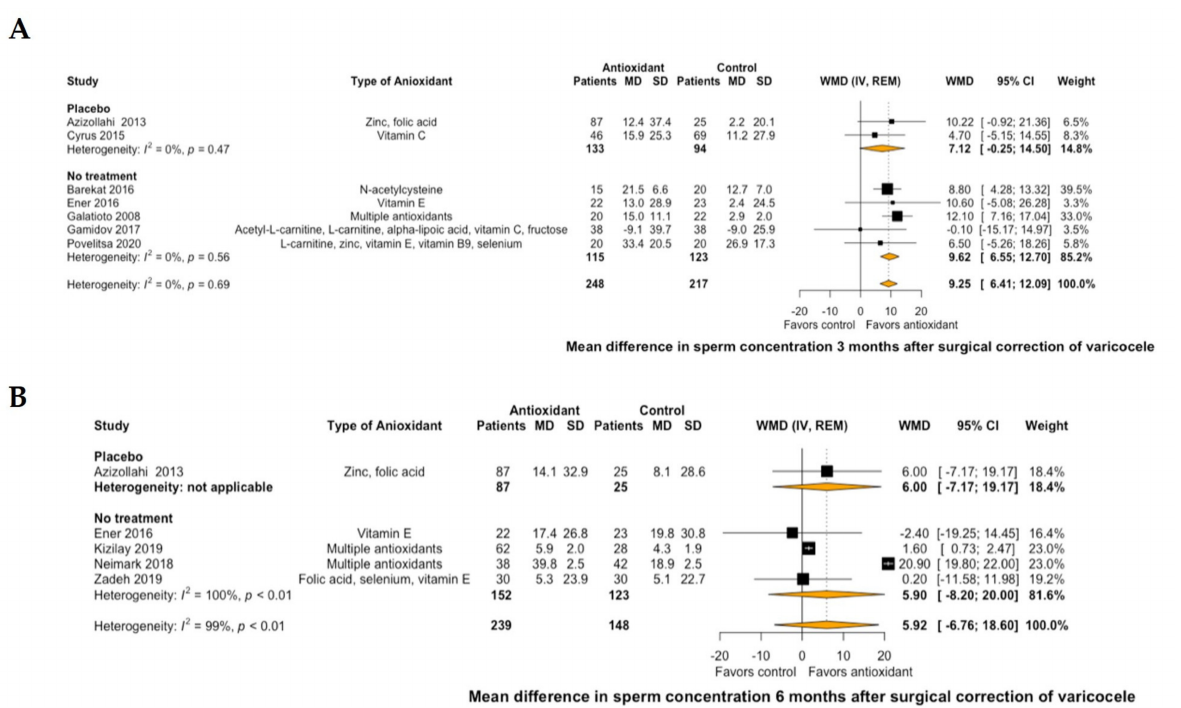
Figure 3. Forest plot of mean difference in sperm concentration at 3 months ( A ) and 6 months ( B ) after treatment with antioxidants versus placebo or no treatment in patients with surgical correction of varicocele. CI: confidence interval; IV: inverse variance; MD: mean difference; REM: random effects model; SD: standard deviation; WMD: weighted mean difference.